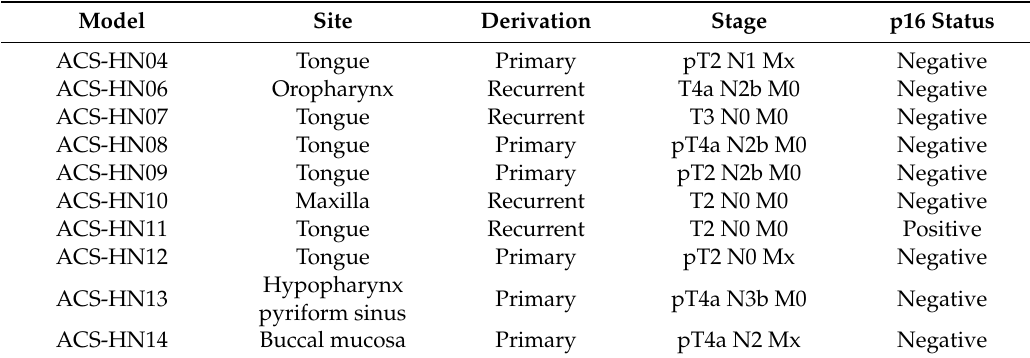
Table 1. Characteristics of patient-derived xenograft (PDX)